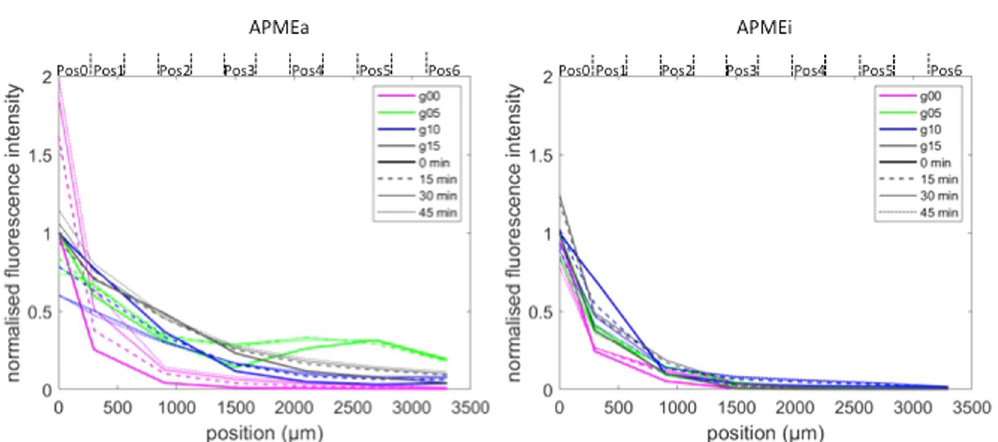
Figure 6. Evolution of fluorescence intensity as a function of Position. The fluorescent intensities were extracted from images acquired on all positions at 0, 15, 30 and 45 min for the native (APMEa) and the heat- inactivated (APMEi) enzyme. The intensity values were normalized on the values at Pos0 and T0 for each kinetic experiment. The gels were prepared by mixing 1.5% LM pectin with no cellulose (g00, pink), 0.5% cellulose (g05, green), 1.0% cellulose (g10, blue), 1.5% cellulose (g15,